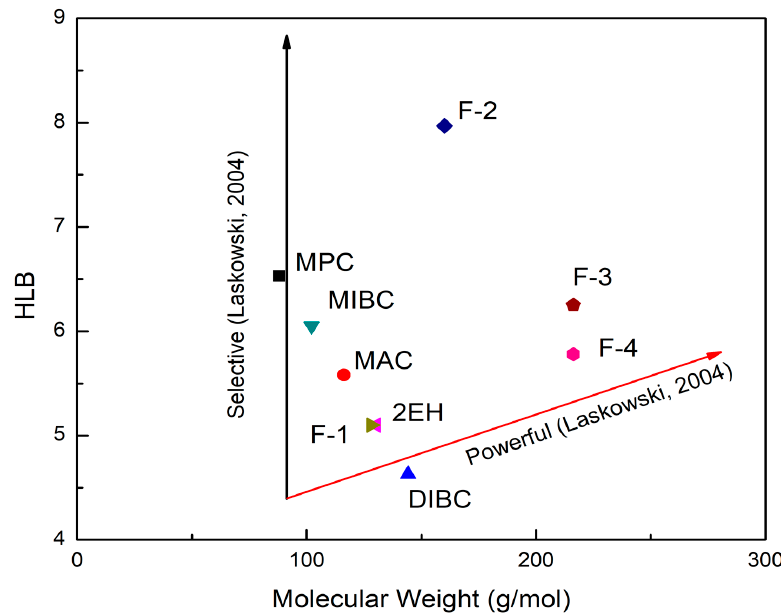
Figure 4. The hydrophile–lipophile balance (HLB)–molecular weight diagram for the nine evaluated frothers (after [26]).